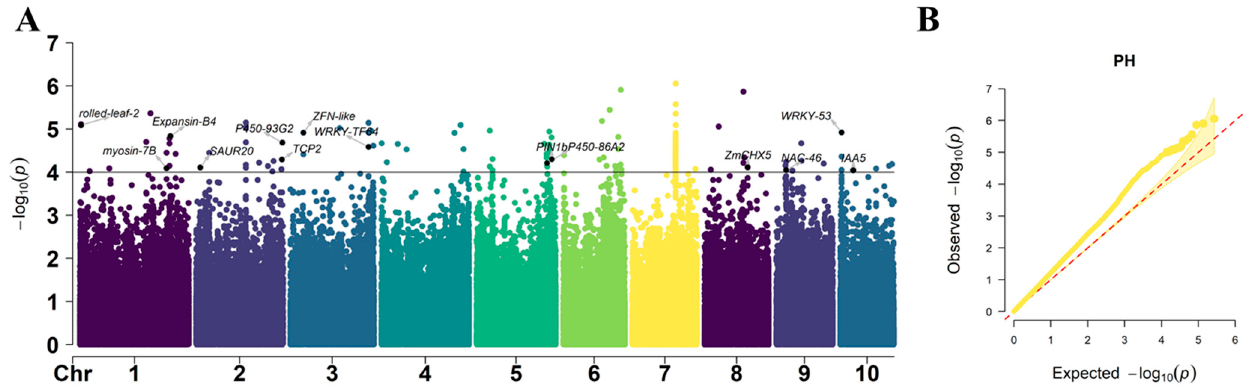
Figure 6. Manhattan plots of GWAS results showing the significant SNPs associated with PH traits. ( A ) Manhattan plot. Each dot represents a SNP. The black solid line represents the threshold of 1× 10 –4 . ( B ) Quantile–Quantile (Q–Q) plots. The red line is the trend line to which the ideal Q–Q plot in each case should correspond.